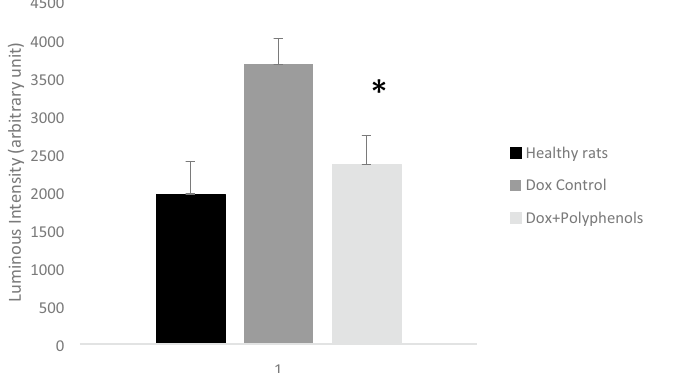
Figure 2. Catalase activity. The graph shows the measurement of hydrogen peroxide substrate remaining after catalase activity. The amount of the remaining substrate is conversely proportional to the antioxidant activity of catalase. Thus, high reading indicates low enzymatic activity. Results presented are mean ± standard error of the mean of 5 independent experiments from 6 different animals per each treatment group. * Represents significance difference (α < 0.05).